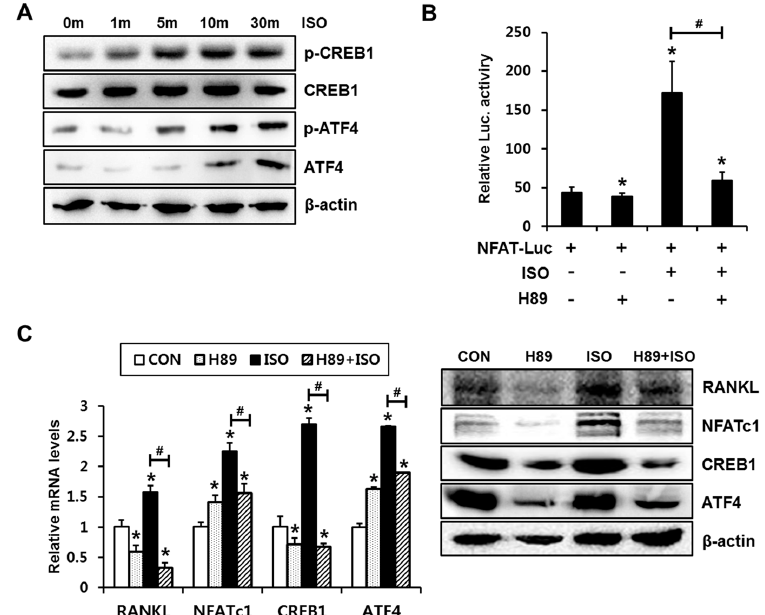
Figure 2. PKA signaling is involved in ISO-induced NFATc1 activation and expression in C2C12 cells. ( A ) ISO induced CREB1 and ATF4 phosphorylation. C2C12 cells were incubated with ISO for the